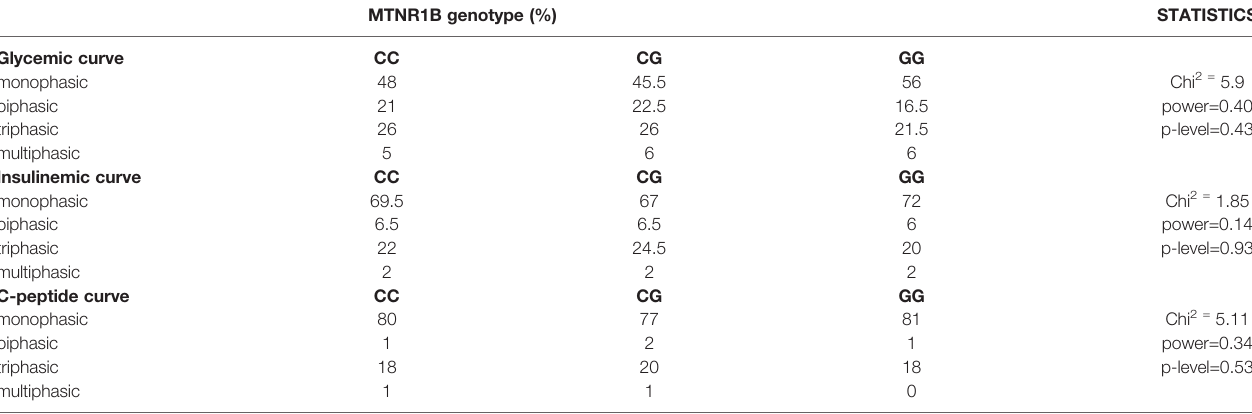
TABLE 3 | Proportions of the MTNR1B rs10830963 genotype depending on the shape of glycemic, insulinemic and C-peptide